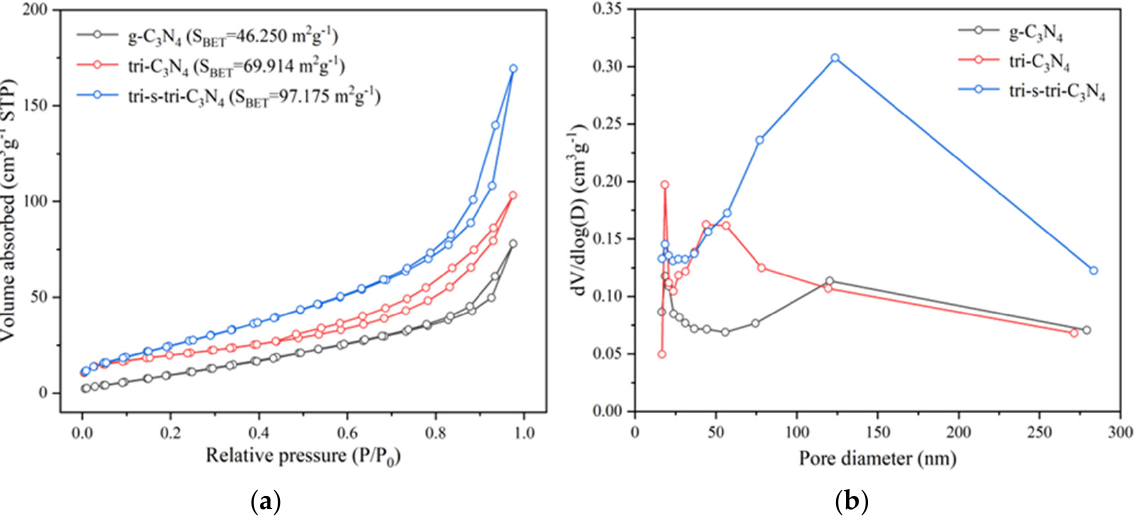
Figure 4. N 2 adsorption–desorption isotherms ( a ) and corresponding pore-size distribution plots ( b ) of g-C 3 N 4 , tri-C 3 N 4 , and tri-s-tri-C 3 N 4 .